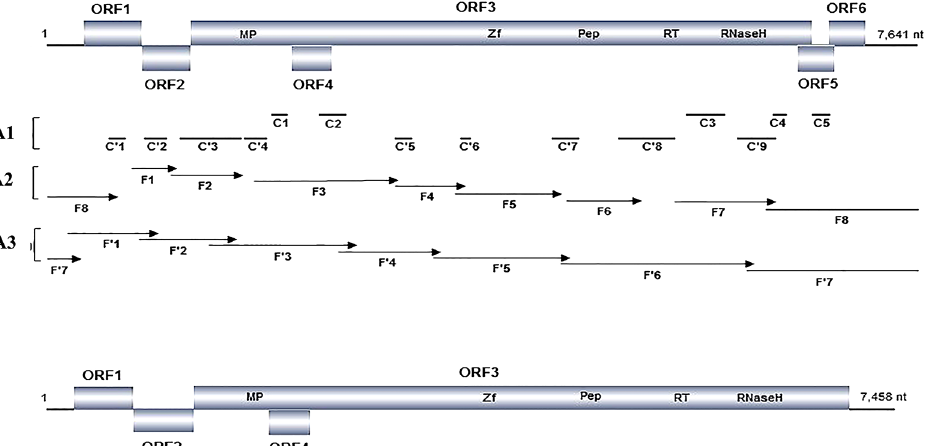
Fig 1. Genome organization of Taro bacilliform CH virus (TaBCHV). The putative ORFs of TaBCHV are indicated by rectangles, domains identified within ORF 3 are shown (A), contigs obtained from samples T1 (C1 – C5) and T2 (C'1 – C'9) are presented by black lines (A1), and fragments F1 – F8 amplified from the first cycle of PCR (A2) and F'1 – F'7 amplified from the second cycle of PCR (A3) are represented by arrows. The genome organization of Taro bacilliform virus (TaBV) (B) is outlined to show its difference with that of